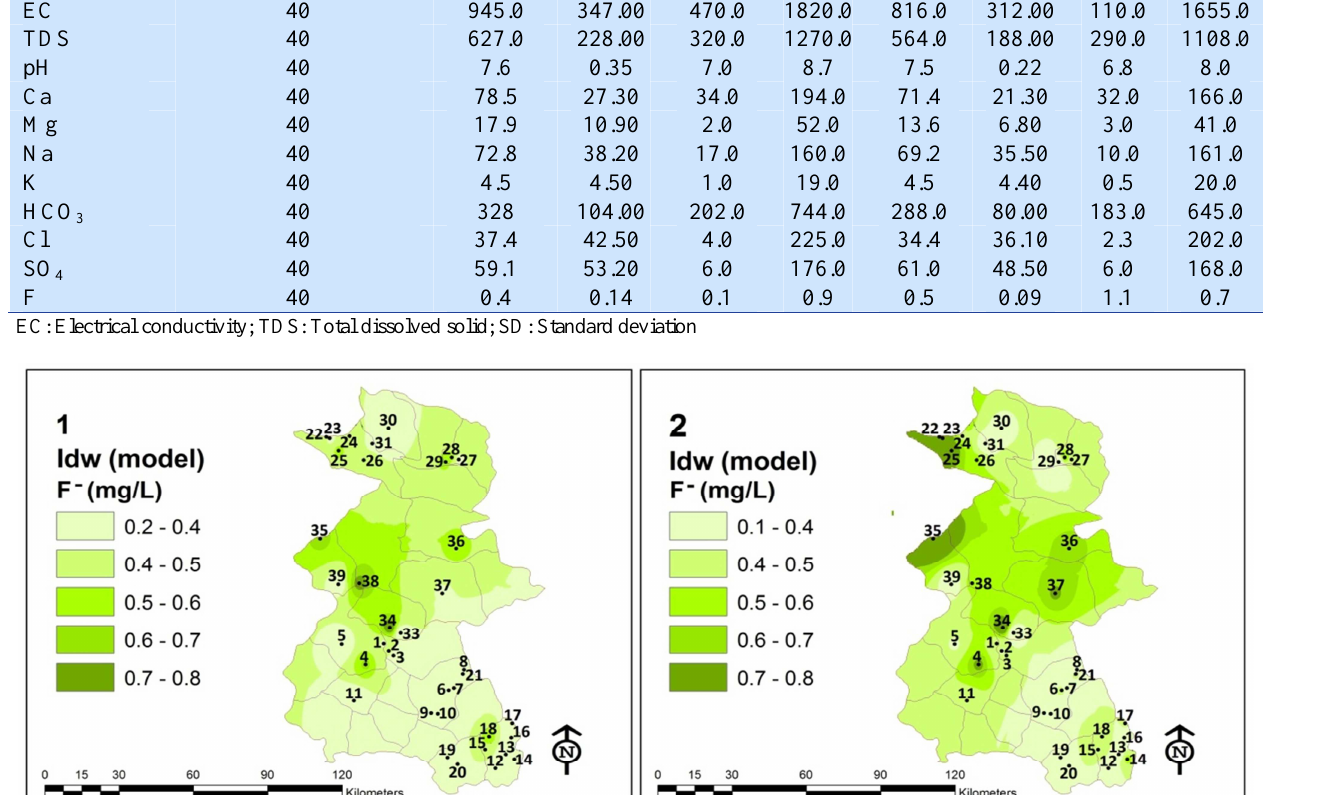
Table 3. Descriptive statistics of elemental concentration for the studied parameters Parameter